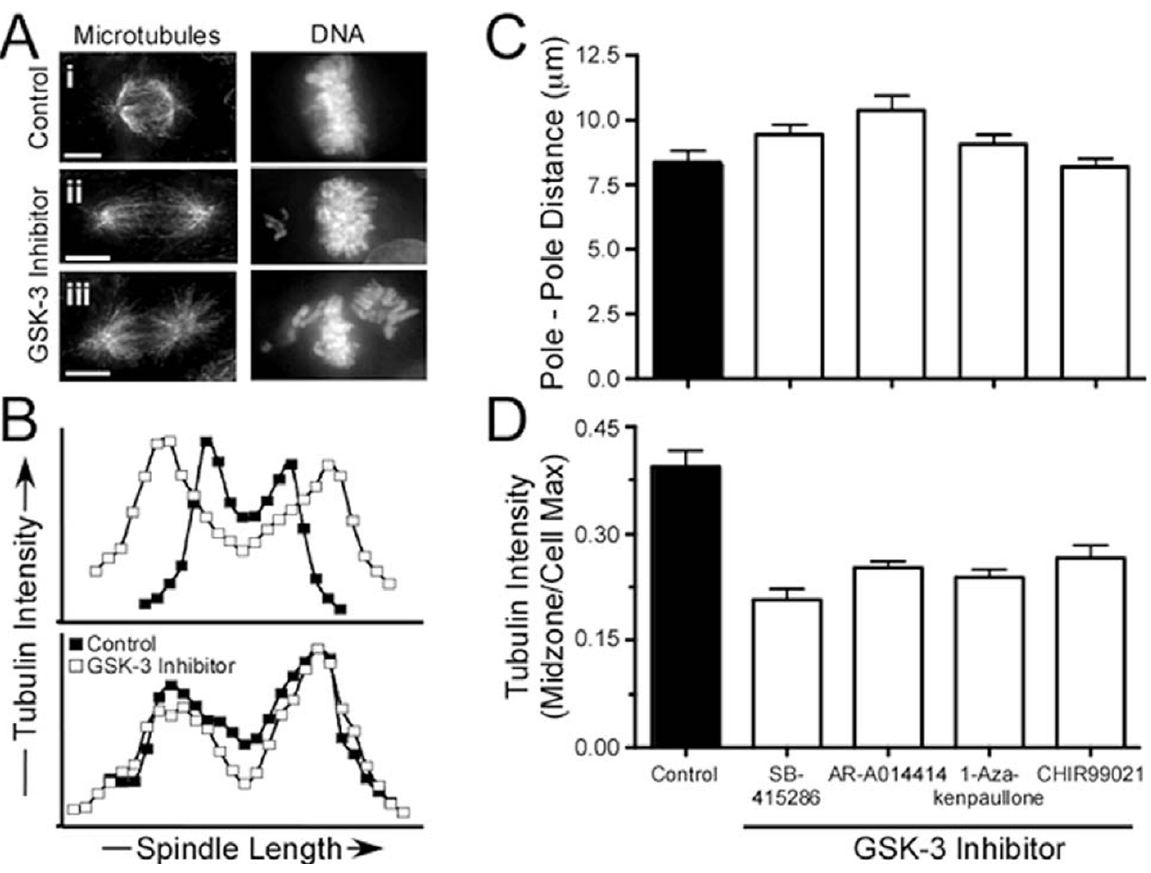
GSK-3 inhibitors weaken the spindle midzone . DLD-1 cells were incubated for 24 hours with GSK-3 inhibitors then fixed and stained to detect the microtubules and the chromosomes. ( A ) Projections of deconvolved image stacks showing rep- resentative mitotic spindles. Scale bar: 5 µ m. ( B ) Graphs plotting tubulin intensity along the spindle axis. ( C ) Bar graphs plotting pole-pole distance. Values represent the mean and s.e.m. derived from at least 18 cells. ( D ) Bar graphs quantifying the tubulin intensity at the spindle midzone. Values represent the mean and s.e.m. derived from at least 15 cells. The cells in parts A-B were treated with either 2.5 µ M 1-Azakenpaullone or 30 µ M